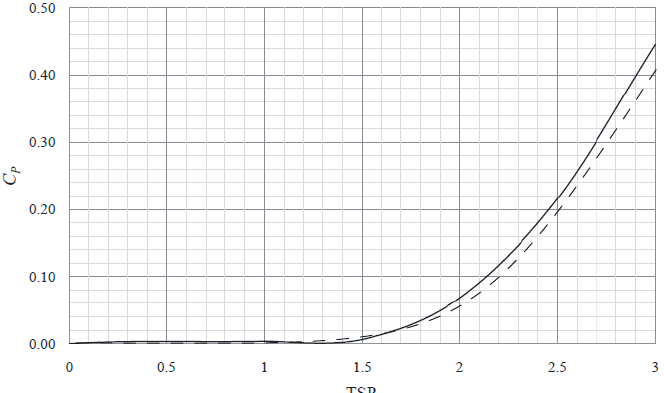
Figure 31. Coefficient of power as a function of TSR for three-bladed VAWT.